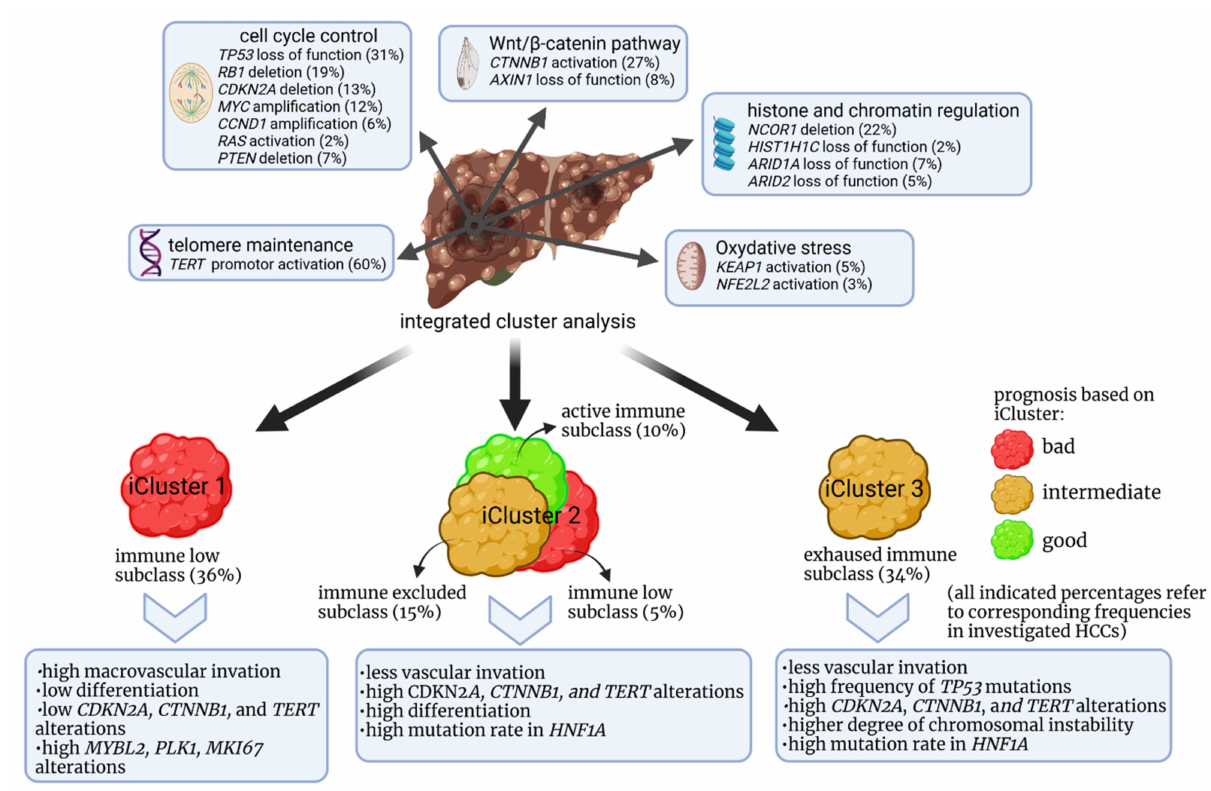
Figure 2. Proposed immune-genetic classification after integrated cluster analysis of HCC and influence on the prognosis established by the Cancer Genome Atlas Research Network